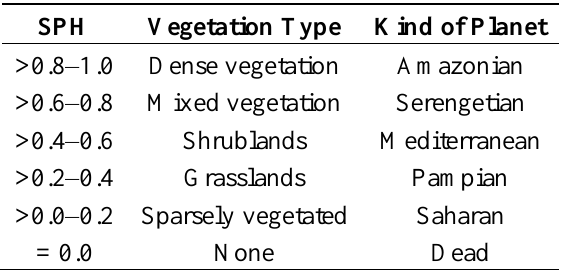
Table 1. Planetary Habitability Classification based on Standard Primary Habitability